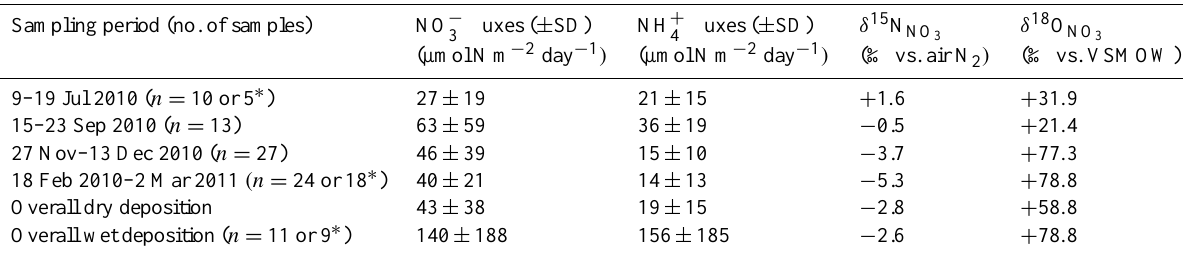
Table 1. Statistical summary of average fluxes of atmospheric nitrate and ammonium depositions and flux-weighted isotopic compositions of nitrate during the sampling